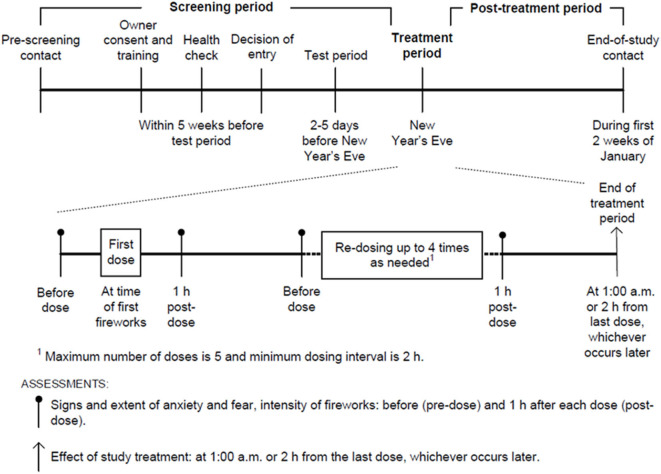
Diagram showing the study design.